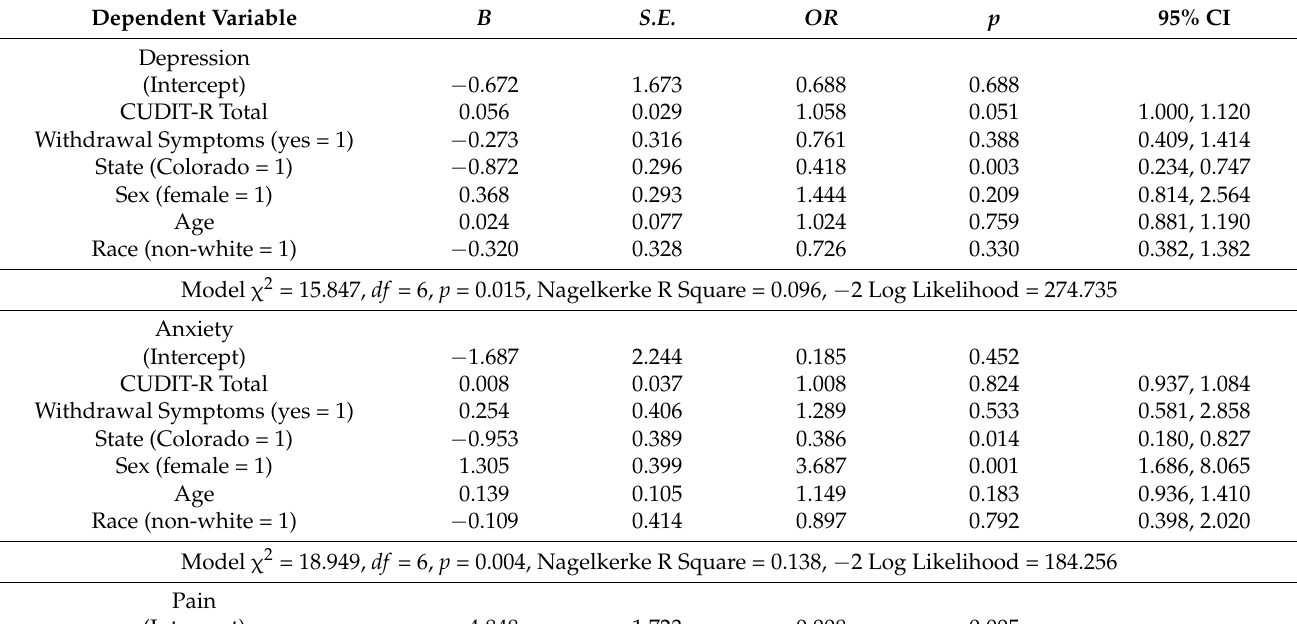
Table 4. Results of logistic regression predicting self-medication reasons with CUDIT-R, sex, state, withdrawal endorsement, controlling for age and race. (N =